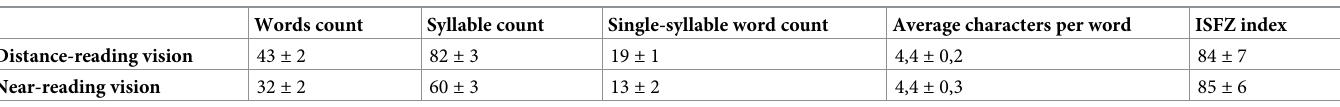
Table 1. Characteristics of texts (words count, syllable count, single syllable word count, average characteristics per word and ISFZ index) used for reading assess- ment at distance and near vision. Words